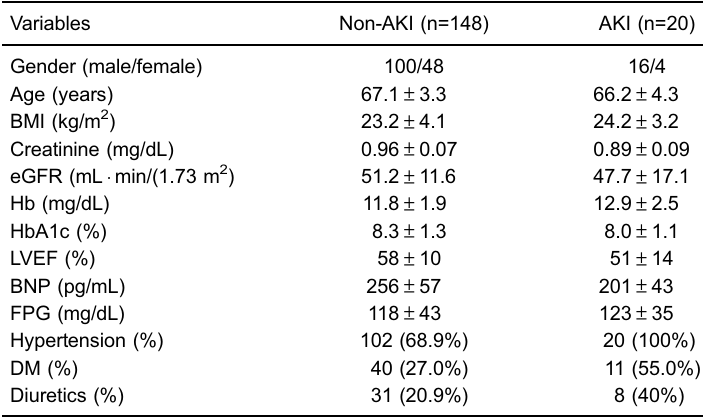
Data are reported as means ± SD or number and percentage. BMI: body mass index; eGRF: estimated glomerular fi ltration rate; Hb: hemoglobin; HbA1c: hemoglobin A1c; LVEF: left ventricular ejection fraction. BNP: brain natriuretic peptide; FPG: fasting plasma glucose; DM: diabetes mellitus. Statistical